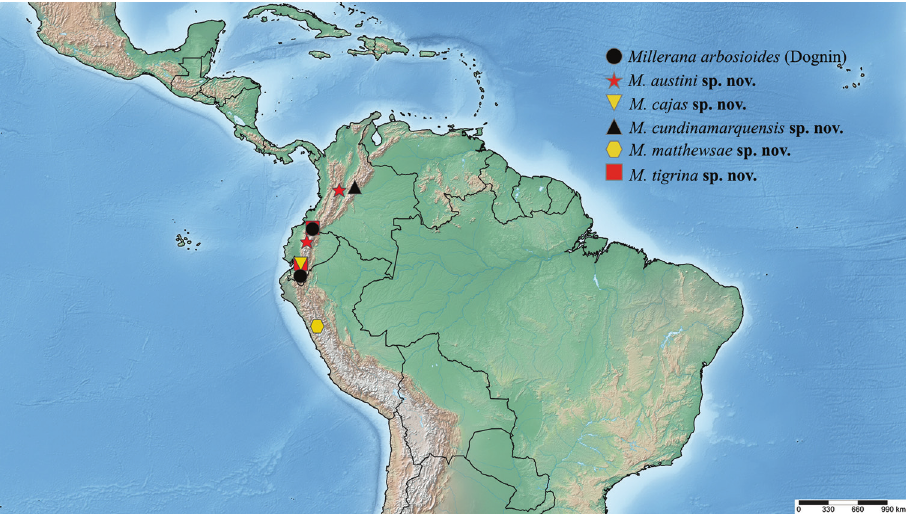
Figure 94. Distribution of examined specimens of the genus Millerana .